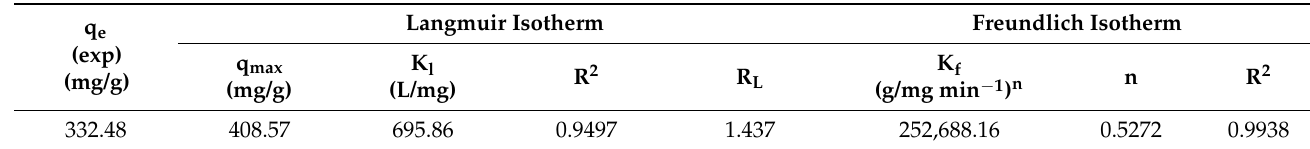
Table 3. Adsorption isotherm model of AR88 onto ZL–CH